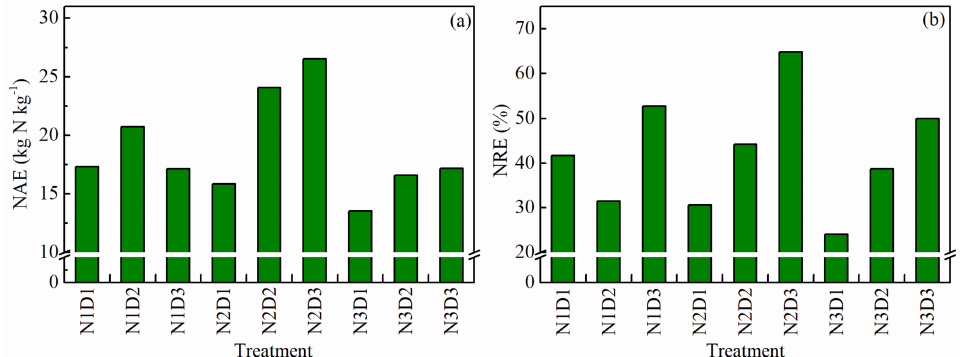
Figure 9. N agronomic efficiency and requirement under different N rates and plating densities in the perennial rice cropping system. ( a ) N agronomic efficiency (NAE) of other further additional treatments. ( b ) N recovery efficiency (NRE) of different